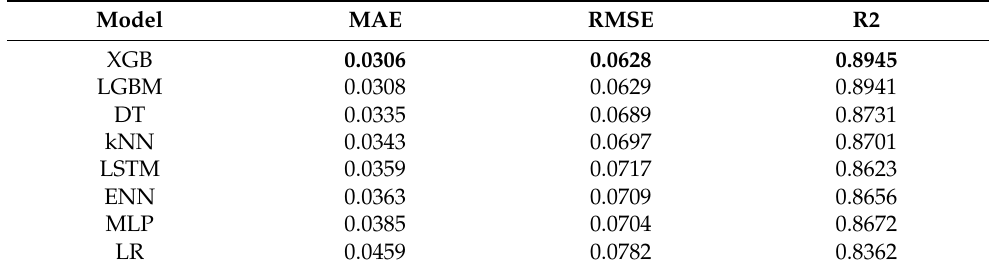
Table 4. Summary of the results obtained, sorted by MAE with the best metric in bold. Model MAE RMSE R2 XGB 0.0306 0.0628 0.8945 LGBM 0.0308 0.0629 0.8941 DT 0.0335 0.0689 0.8731 kNN 0.0343 0.0697 0.8701 LSTM 0.0359 0.0717 0.8623 ENN 0.0363 0.0709 0.8656 MLP 0.0385 0.0704 0.8672 LR 0.0459 0.0782